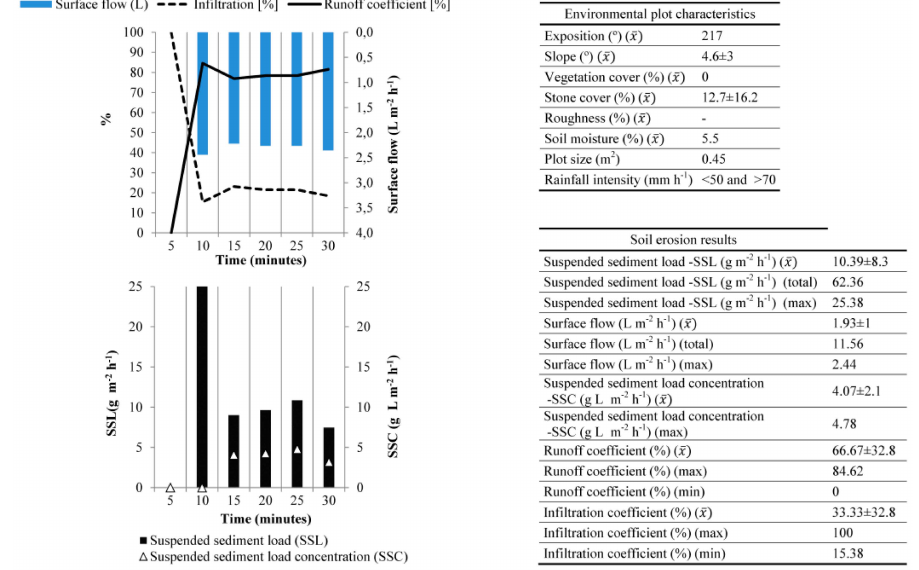
Figure 7. Rainfall simulations in Villamediana de Iregua (La Rioja,